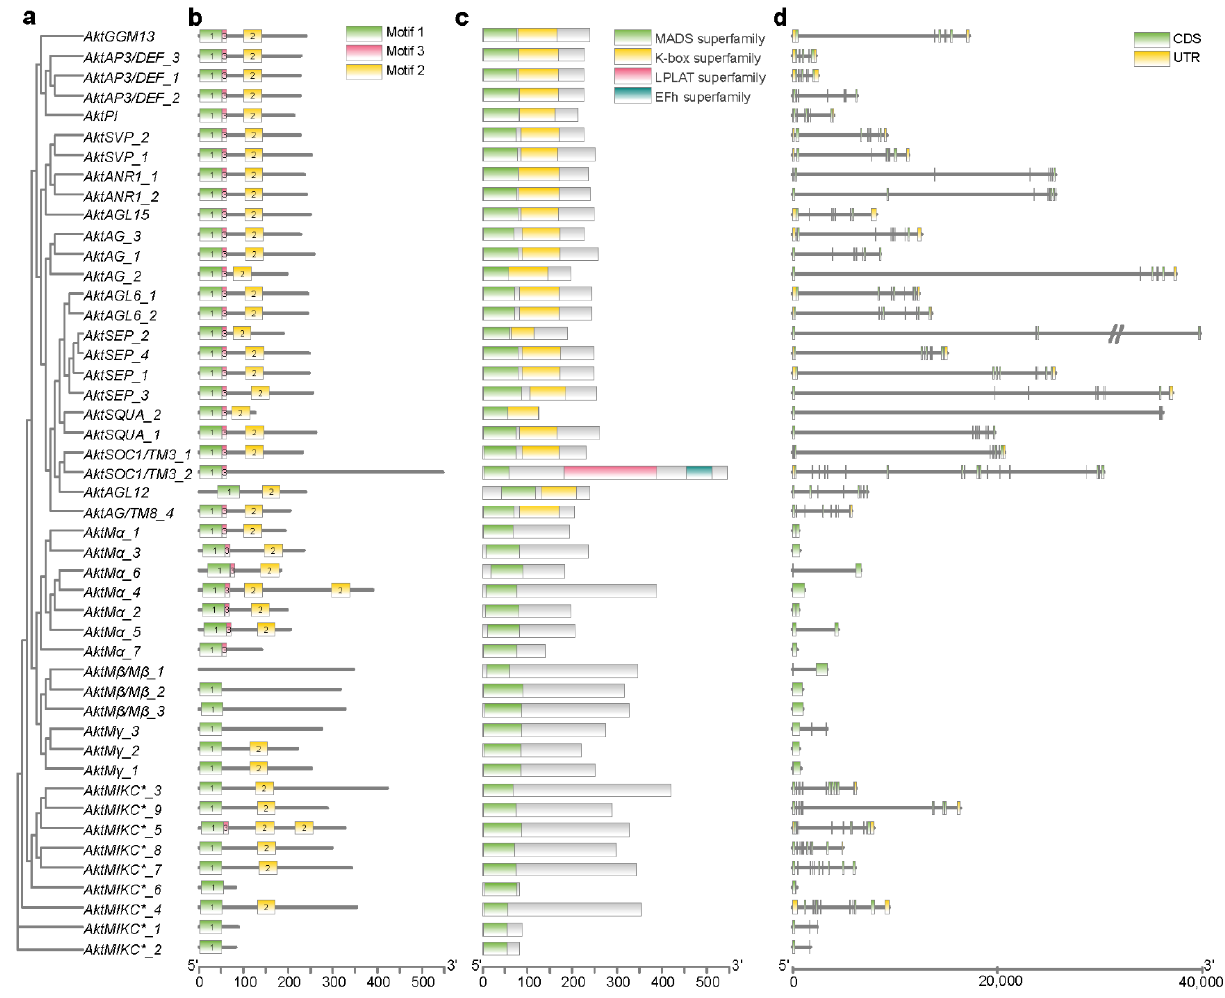
Figure 2. Gene and protein structures of the MADS-box gene families in A. trifoliata . ( a ) Phylogenetic tree of A. trifoliata MADS-box genes; ( b ) Motifs of MADS-box proteins. ( c ) Conserved domains of MADS-box proteins; ( d ) Exon-intron structures of MADS-box genes.